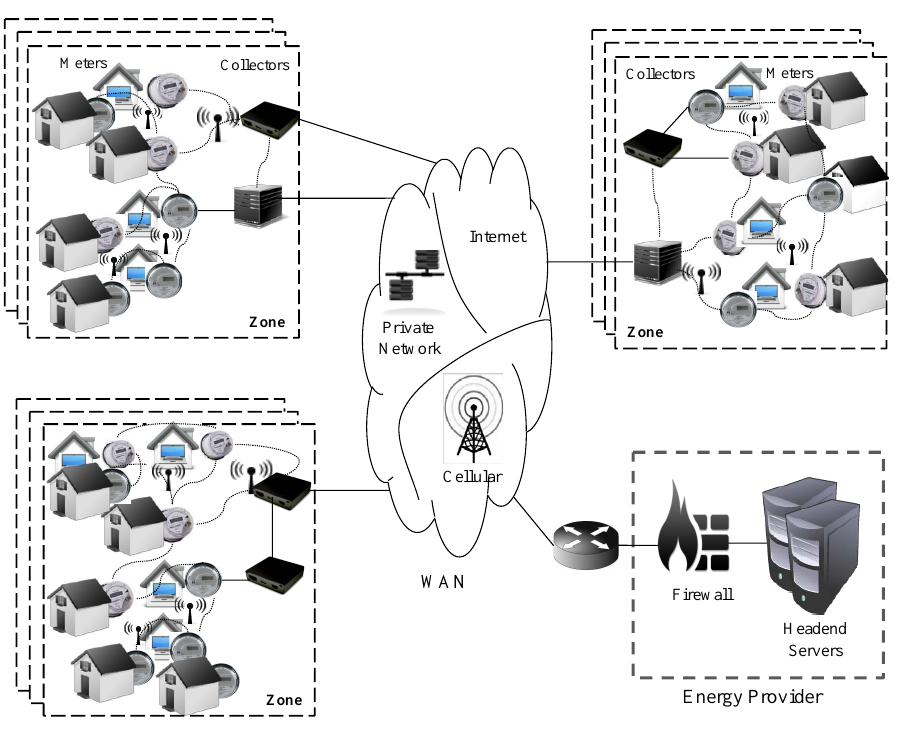
Figure 1. An example topology of an AMI, which often consists of many zones of smart meters where each zone usually represents meters located in geographically close one or more